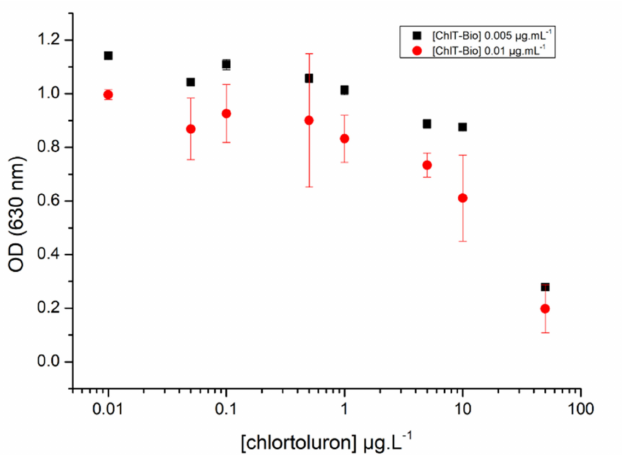
Figure 4. Absorbance measurements at 630 nm obtained after incubation of monoclonal antibody at 0.16 µ g · mL − 1 with chlortoluron at concentrations ranging from 0.05 at 50 µ g · L − 1 , and using two concentrations of biotinylated chlortoluron (ChlT-Bio) (0.005 and 0.01 µ g · mL − 1 ) (assays in triplicate). No significant differences were observed using the two concentrations of biotinylated chlortoluron tested. For a chlortoluron concentration of 1 µ g · L − 1 , absorbance values of 0.83 and 1.01 (%B/B 0 of 81.5% and 87.6%) were obtained using biotinylated